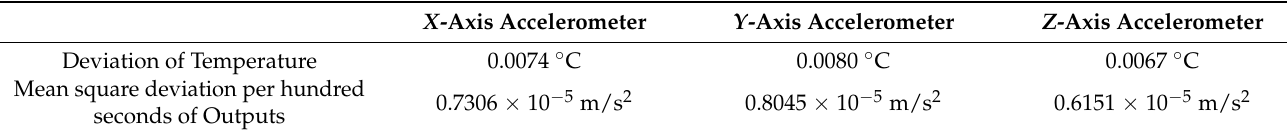
Table 4. The deviation of accelerometer temperature and mean square deviation per hundred seconds of accelerometer